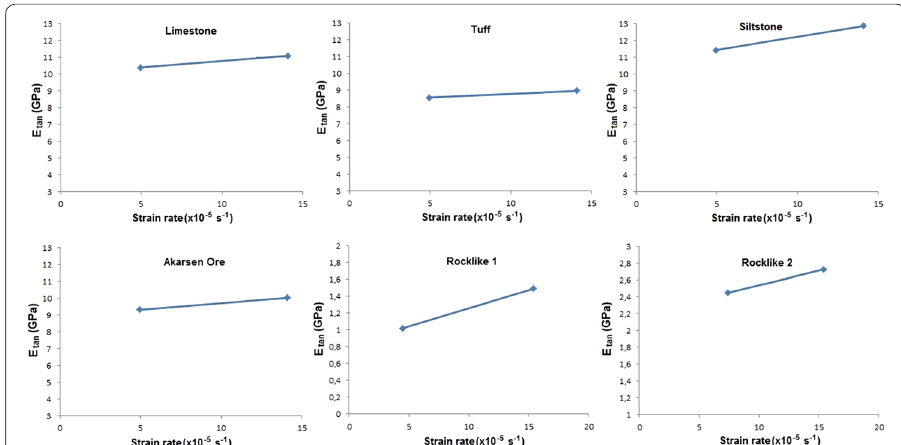
Fig. 9 Tangent modulus of elasticity values